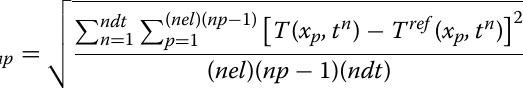
the first and second derivatives of T n to compute F ( x ) with Eq. (23) when calculating the fine scale contributions from Eqs. (27a) and